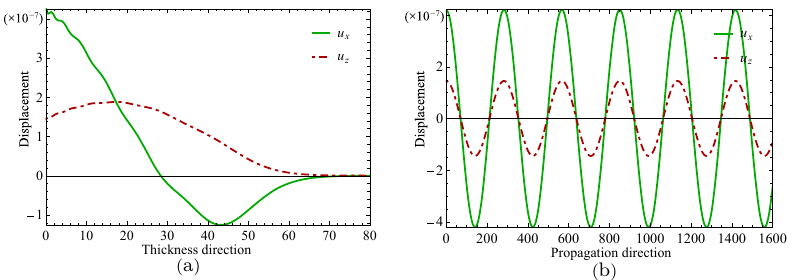
Figure 9. Displacement distributions for thickness direction in ( a ) and propagation direction in ( b ) when f = 24.10 Hz, ξ = 2.2152.